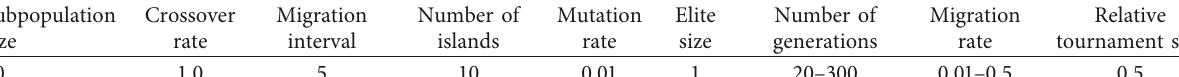
Table 2: MIGA parameters.